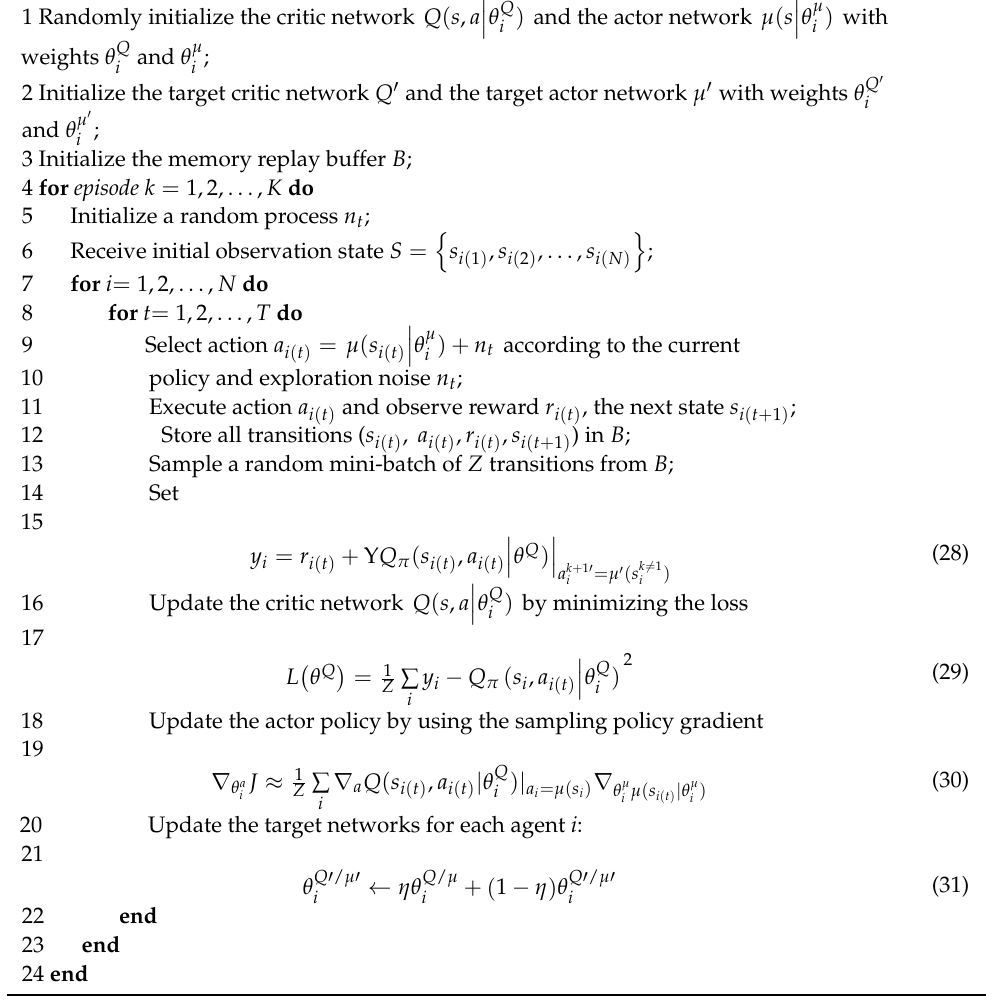
Algorithm 1: Cooperative Optimization for Privacy and Priority based on Deep Deterministic Policy Gradient